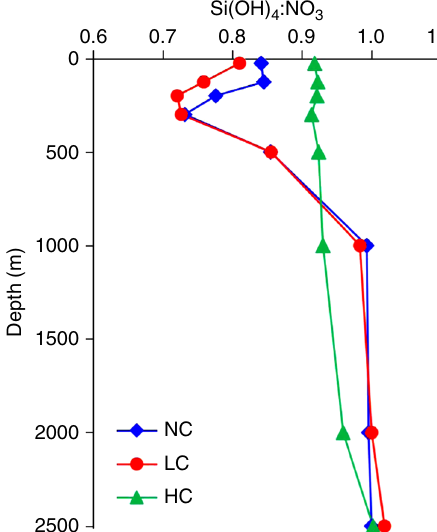
Fig. 3 Vertical Si-N nutrient ratio pro fi les in different regions of the DeWeX cruise. H 4 SiO:NO 3 − (mol:mol) ratio pro fi les in three station clusters (NC: No Convection, LC: Low Convection, HC: High Convection) based on hierarchical clustering of the depth extent of the winter mixing